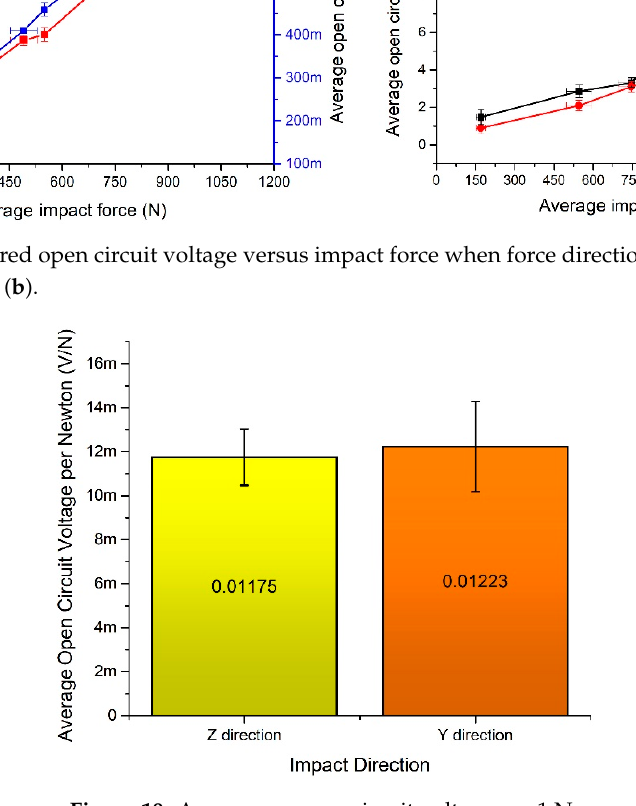
Figure 18. Measured open circuit voltage versus impact force when force direction is aligned with y axis ( a ) and z axis ( b ).